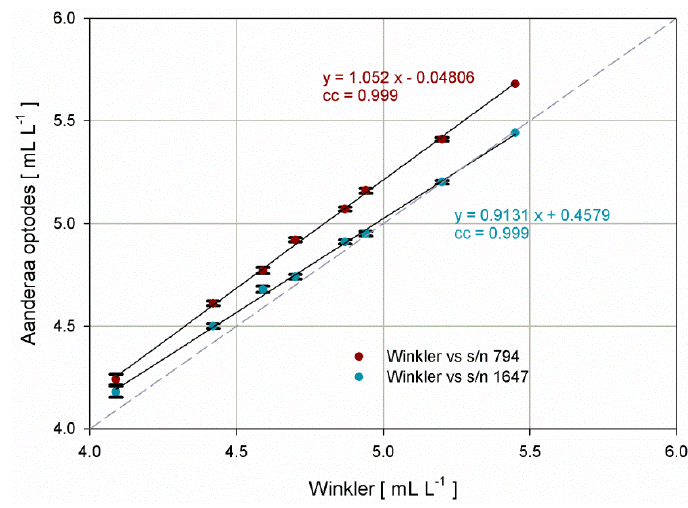
Figure 2. Dispersion diagram and linear regression between the results of the Winkler analytic method and the concentrations provided by two Aanderaa optodes model 3975 under analysis. Error bars represent the standard deviation, whereas dashed line represents the 1:1 relationship.